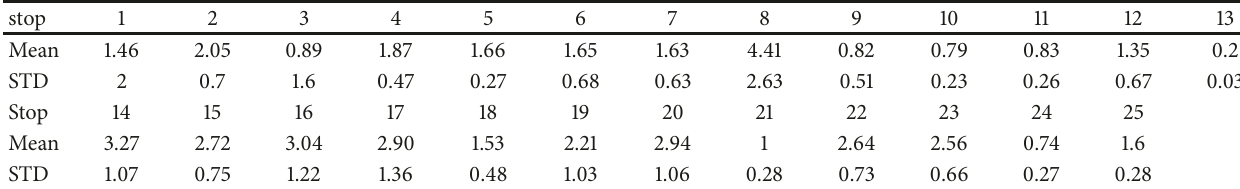
Table 2: Observed mean and standard deviation of link travel times on 87 Route (unit: